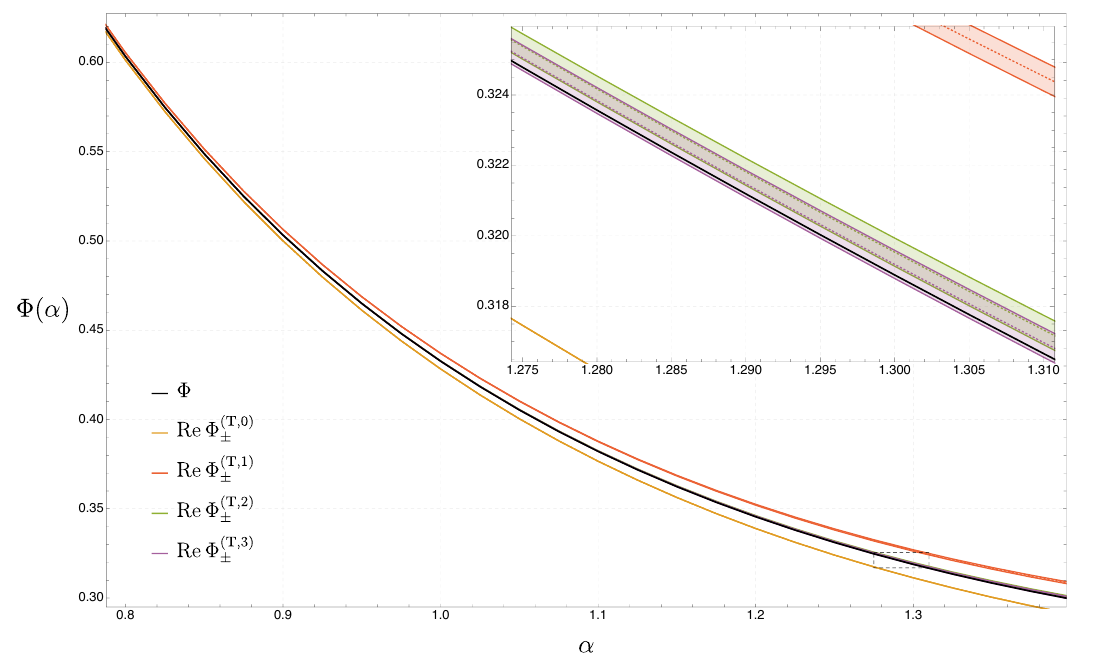
Figure 2 . Leading rescaled free energy Φ as a function of the coupling α . The black line corresponds to the exact result, the orange, red, green and blue lines to the approximate result given by Borel resumming the first series in the trans-series, as in the legend. The box to the bottom-right is a zoom of the region marked by the dashed black rectangle above. The dashed lines are the central values, while the shaded area corresponds to the error associated to the Borel resummation, as explained in the main